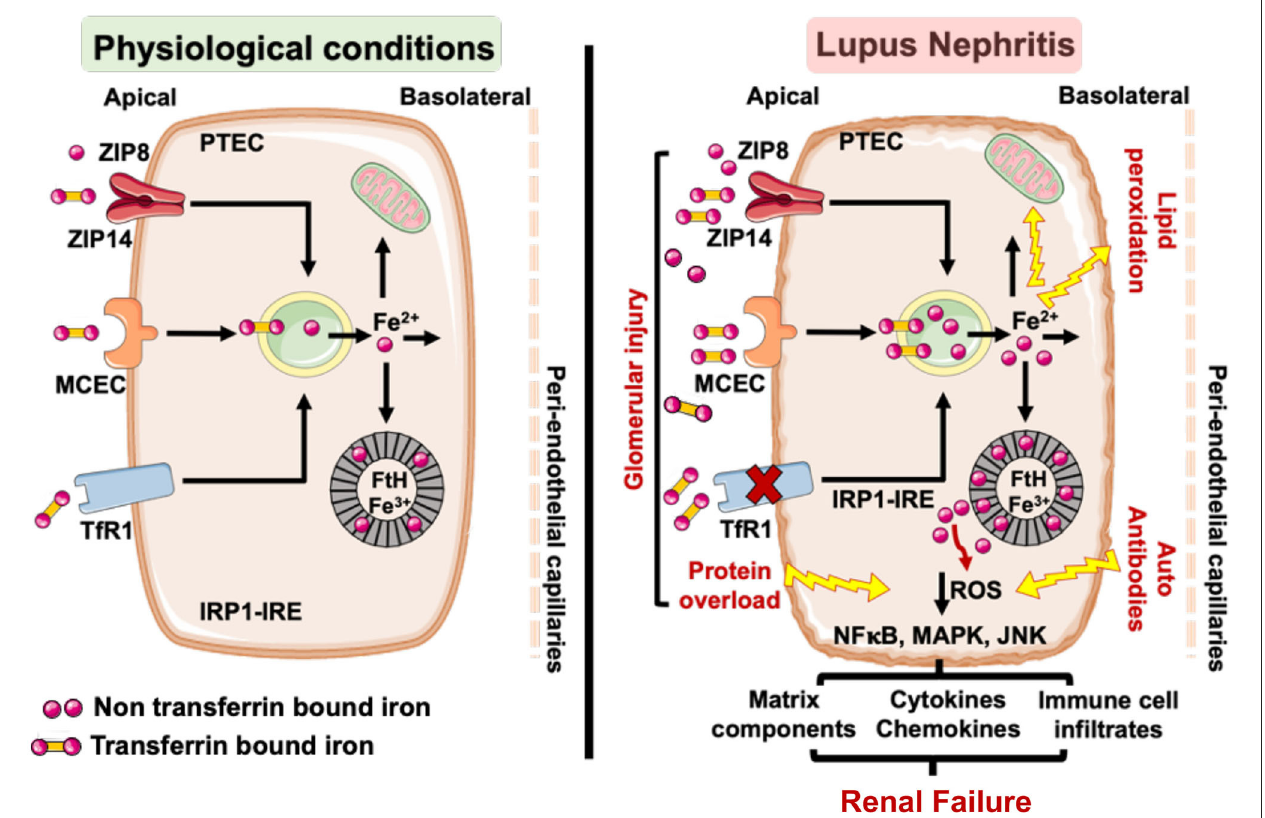
FIGURE 3 | Under physiological conditions little transferrin bound (TBI) and non-transferrin bound iron (NTBI) is filtered by the glomerular assembly and is reabsorbed and cycled by the proximal tubular cells (PTEC). However, in LN, glomerular injury results in an increased leakage of TBI and NTBI, which can be reabsorbed by the PTEC via TfR1, ZIP8/14, and MCEC. While TfR1 is regulated by the IRP-IRE system, ZIP8/14, and MCEC are not and can continue to absorb the leaking TBI and NTBI to iron overload the PTEC. This can overwhelm the heavy chain ferritin (FtH) iron binding capacity, leading to release of labile iron and render the PTEC susceptible to ROS mediated injury and lipid peroxidation. The glomerulopathy associated protein overload (e.g., albumin) and lupus autoantibodies can independently induce ROS in the PTEC and activate ROS sensitive inflammatory pathways. The accumulated iron can catalyze ROS formation via the Fenton reaction and exacerbate the inflammatory phenotype of the PTEC to worsen tubulointerstitial injury and accelerate the progression to renal failure. TfR1, transferrin receptor 1; MCEC, megalin cubulin endocytic complex; FtH, heavy chain ferritin; ROS, reactive oxygen species; IRP-IRE, iron regulatory protein-iron response